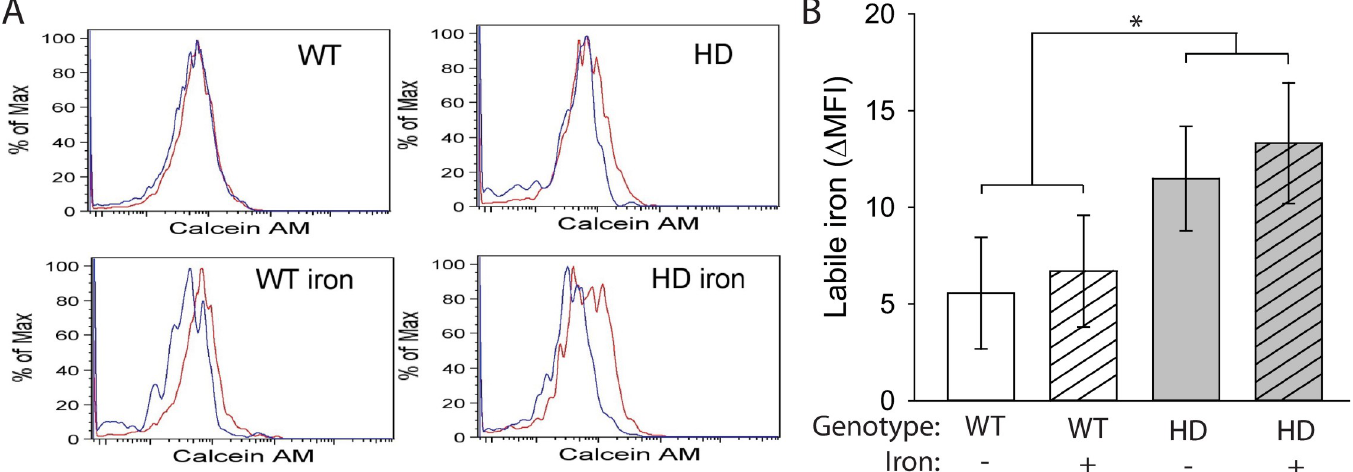
Fig 5. Labile iron accumulates in HD microglia. Microglia, defined as CD11b + CD45 + CX3CR1 + cells, were extracted from mouse brains at 14 weeks of age and labeled with calcein AM. A . Representative histograms of calcein AM fluorescence in brain microglia incubated with (red) or without (blue) deferiprone. B . Labile iron, defined as the difference in mean fluorescence intensity (MFI) between cells incubated with and without deferiprone, was significantly increased in HD microglia. n = 6–8. Data are shown as the mean ± SE. � p < 0.05.